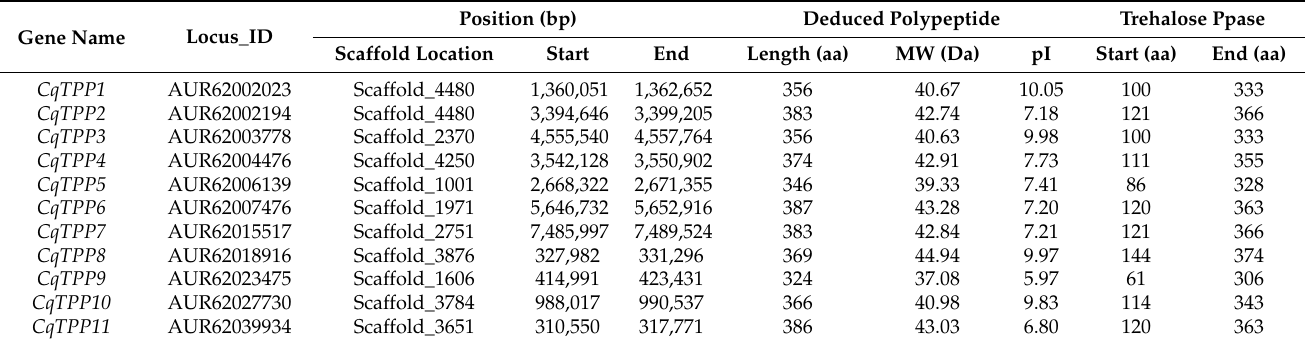
Table 2. Basic information of CqTPP genes in quinoa